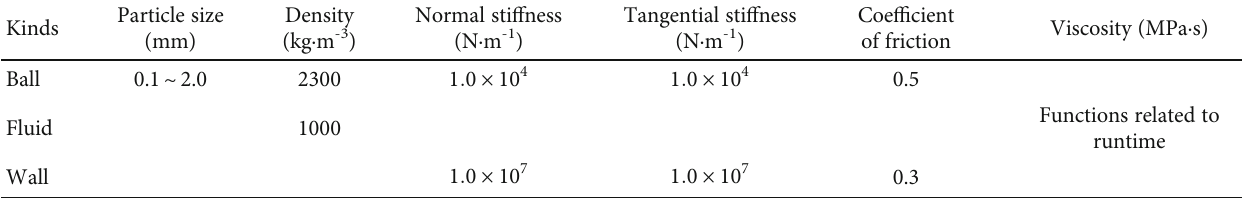
Table 1: Mesoscopic parameters of numerical simulation materials.